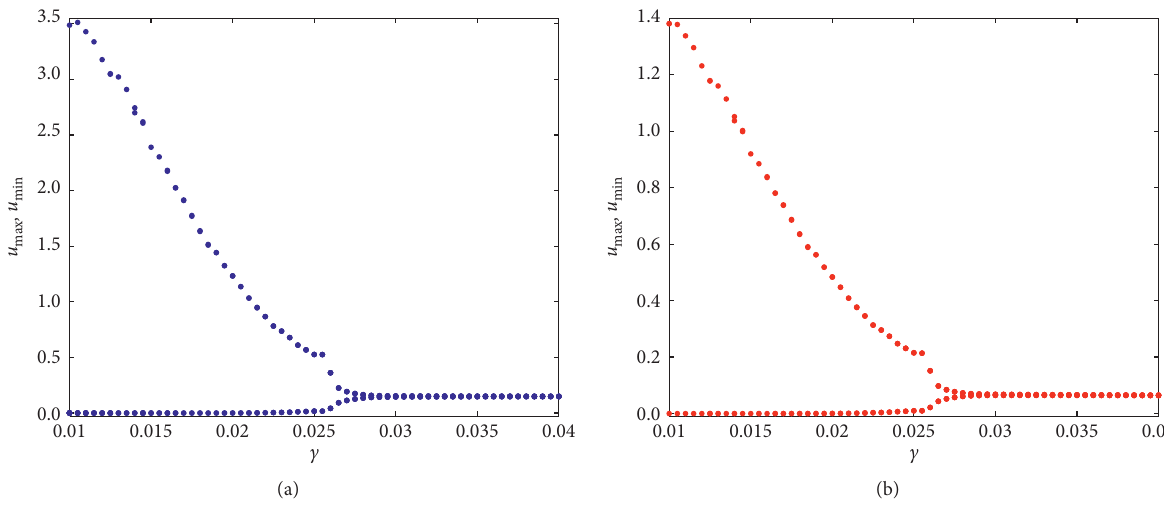
Figure 7: Bifurcation diagram with respect to intraspecific competition between prey species c for predator-prey system (4) with Holling type-II response function. Rest of the parameters r